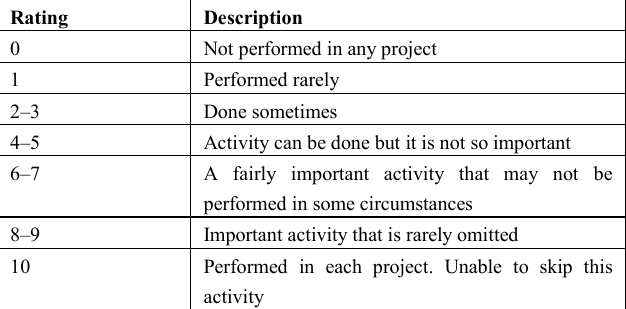
R ATING S CALE OF S OFTWARE D EVELOPMENT A